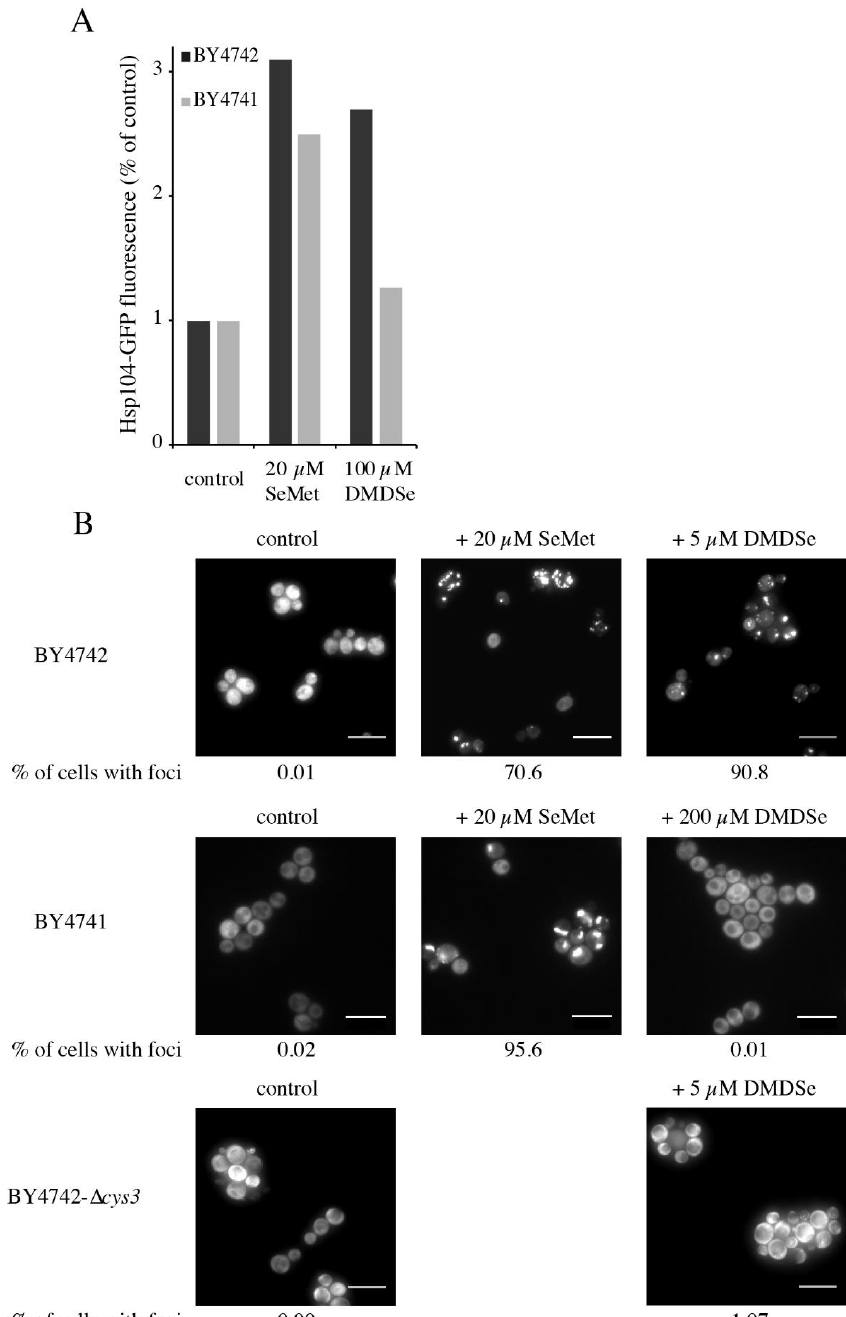
Figure 9. DMDSe promotes protein aggregation in a MET17 -dependent manner. ( A ) Induction of Hsp104-GFP by SeMet or DMDSe. Exponentially growing BY4742-Hsp104-GFP (dark bars) or BY4741-Hsp104-GFP (light bars) cells were incubated in SC + 100 µM methionine for 2 h at 30°C in the absence or presence of the indicated concentration of SeMet or DMDSe. The fluorescence in whole cell extracts was recorded at 508 nm and normalized to the optical density of the extracts at 280 nm. The fluorescence intensity in the absence of toxic (control) was set as 1. ( B ) Localization of Hsp104-GFP in cells exposed to SeMet or DMDSe. Hsp104-GFP localization was monitored by fluorescence in living cells after 1 h of exposure to the indicated concentrations of SeMet or DMDSe. BY4742 and BY4742-∆cys3 cells were grown in SD supplemented with 100 µM cysteine, BY4741 cells were grown in SD supplemented with 100 µM methionine. Representative images obtained after maximum intensity z-projection, bar equals 10 µ m. The fraction of cells containing at least one Hsp104-GFP focus was determined by manual inspection of 100–200 cells in each